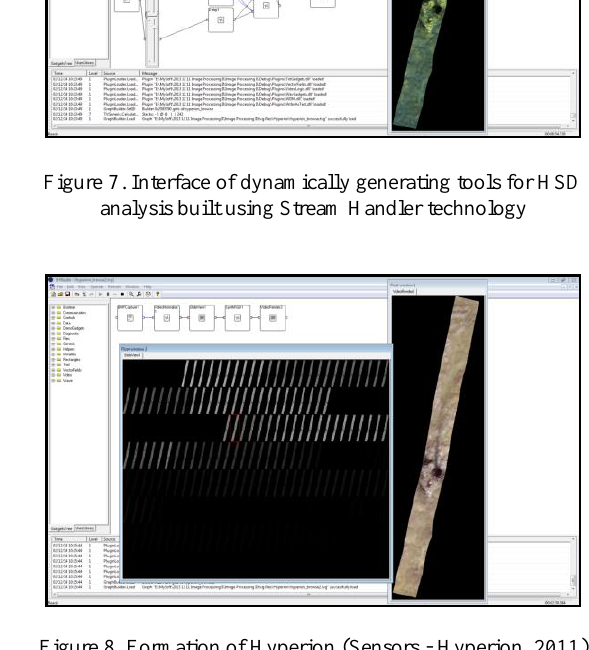
Figure 8. Formation of Hyperion (Sensors - Hyperion,